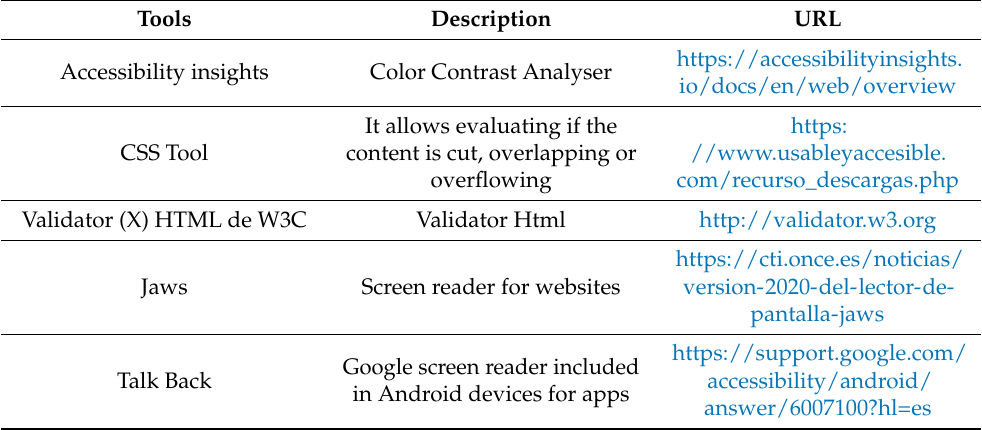
Table 1. Tools used in a complementary way to Wave [54] and Google’s Accessibility Scanner [41].